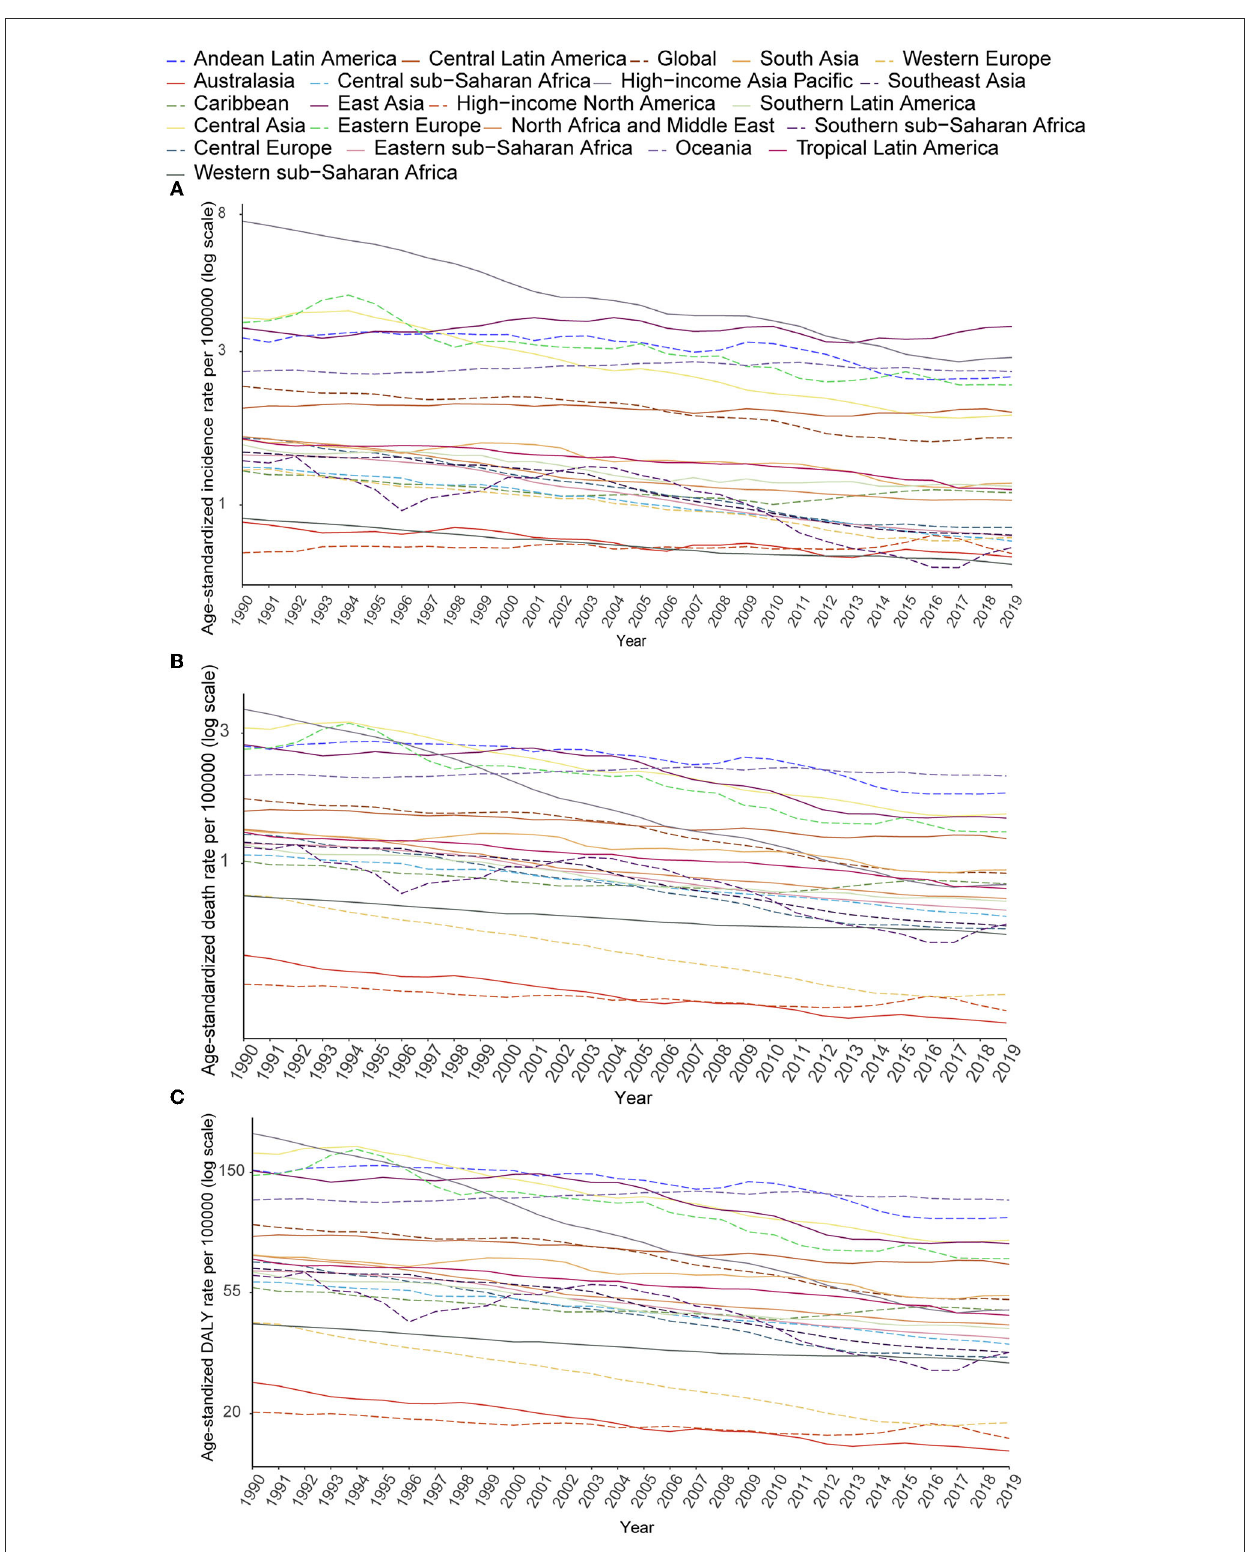
FIGURE5 Secular trends of age-standardized incidence (A) , death (B) , and DALY (C) rates of AYA stomach cancer, 1990–2019, globally, and for 21 GBD regions.